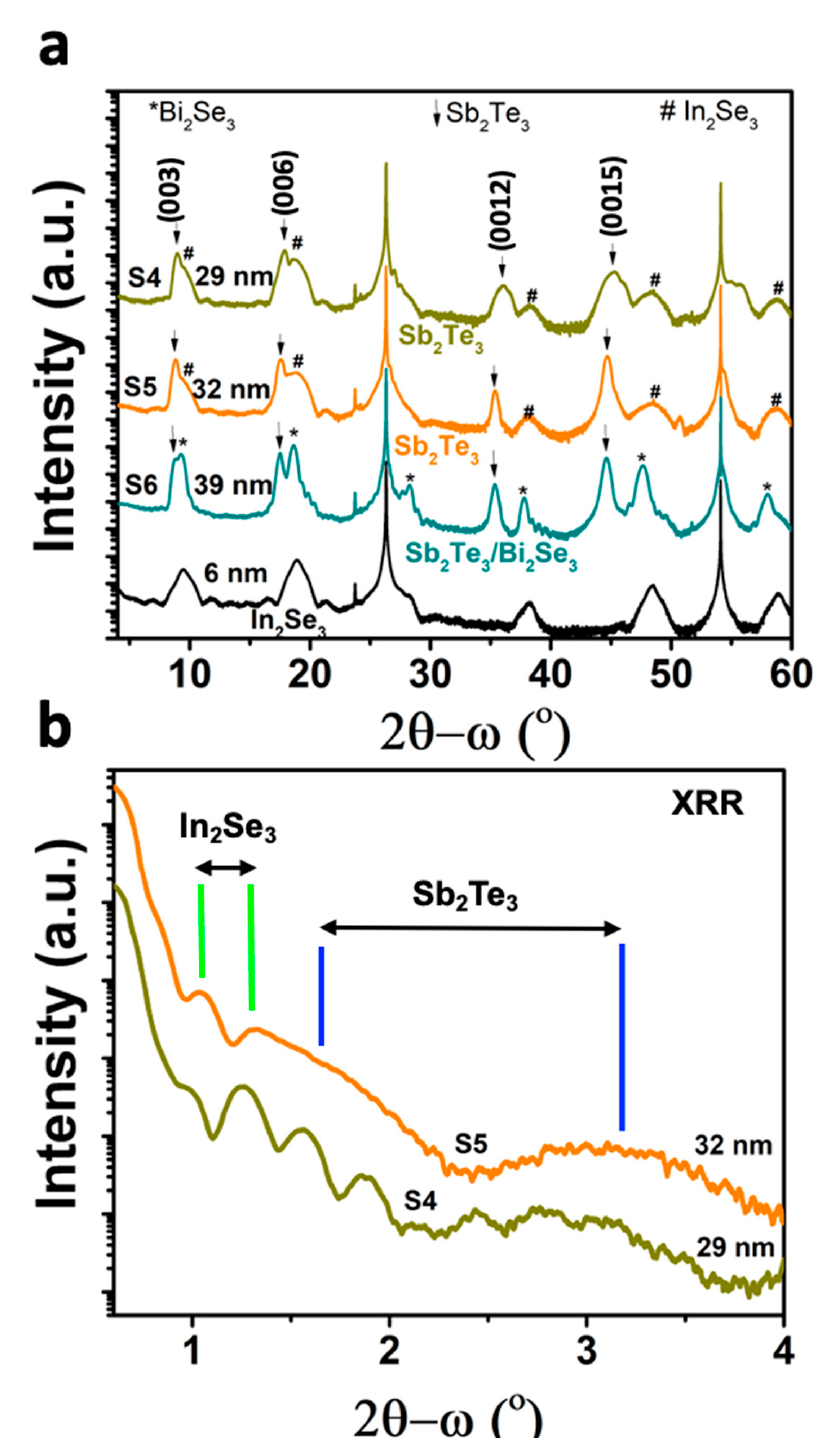
Figure 5. X-ray diffraction (XRD) ( a ) 2 θ - ω scans of Sb 2 Te 3 films with different thicknesses grown at different substrate temperatures (T g ) on In 2 Se 3 layer. ( b ) Sample X-ray reflectivity (XRR) scan of Sb 2 Te 3 films showing two distinct oscillations corresponding to In 2 Se 3 and the Sb 2 Te 3 , from which the layer thicknesses are calculated.